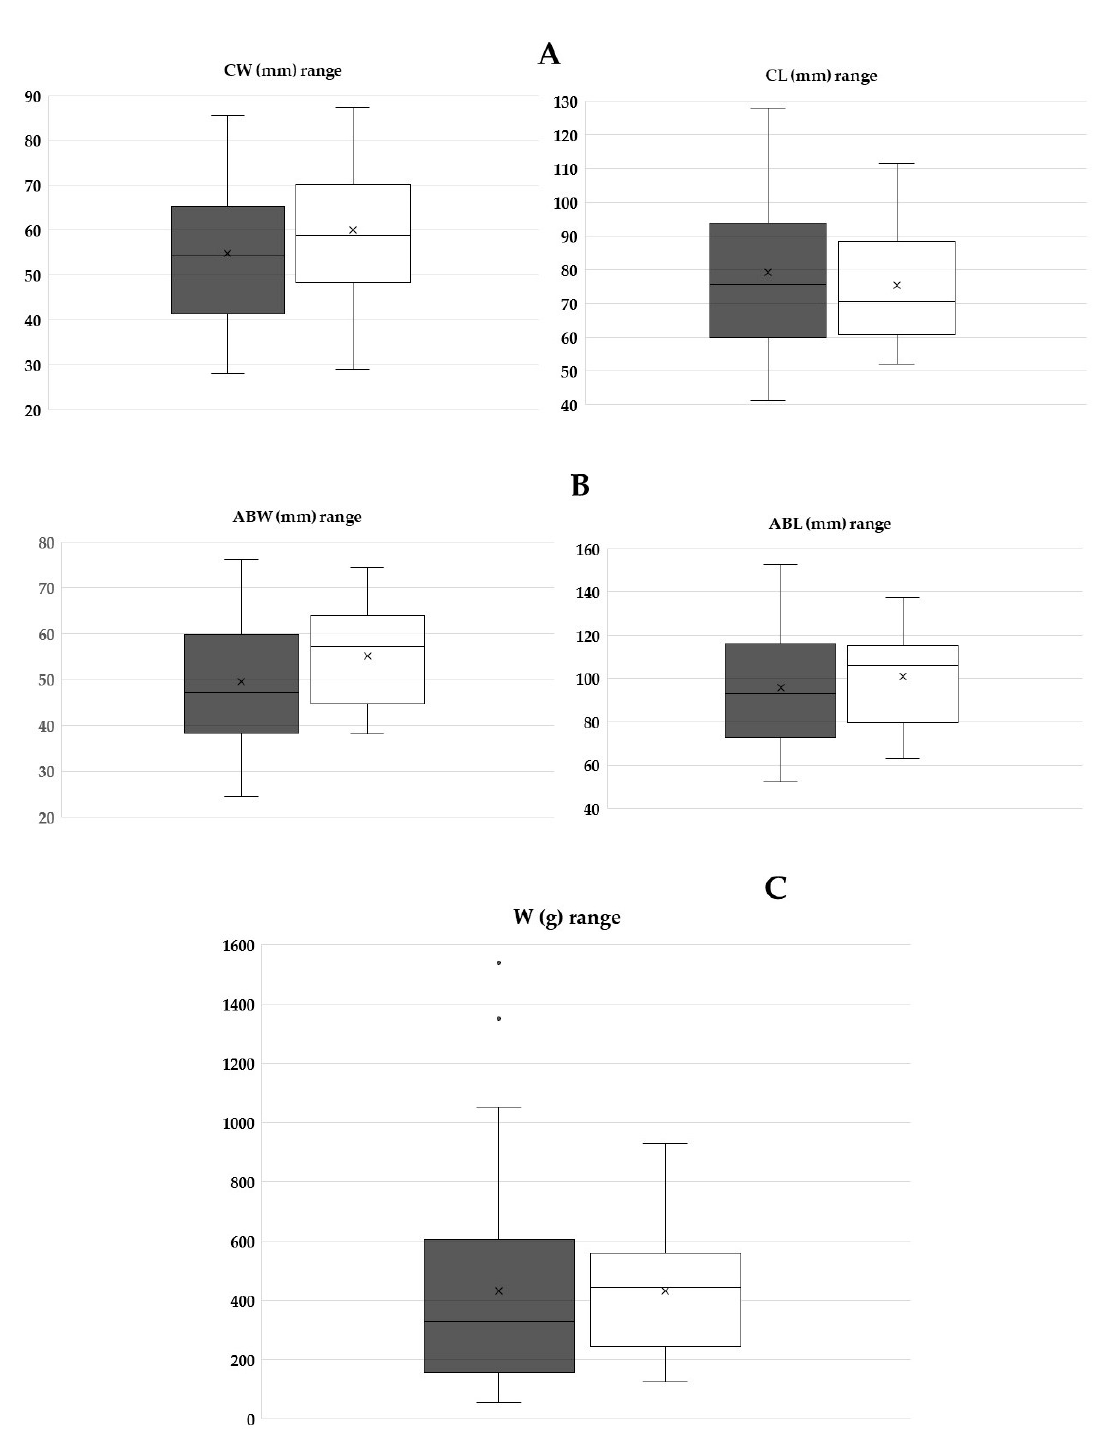
Figure 2. The maximum, average, and minimum values of males (M; black box) and females (F; white box) from the sampling procedure. ( A ) CW and CL; ( B ) ABW and ABL; and ( C ) W. All of the morphometric relationships of both males and females demonstrate negative